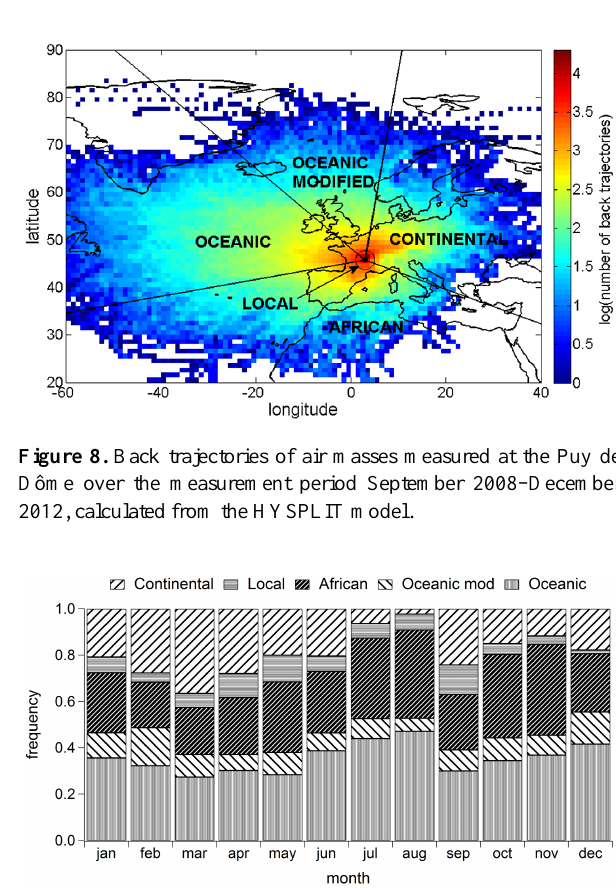
Figure 9. Seasonal variations in back trajectories of air masses mea- sured at the Puy de Dôme over the measurement period September 2008–December 2012.